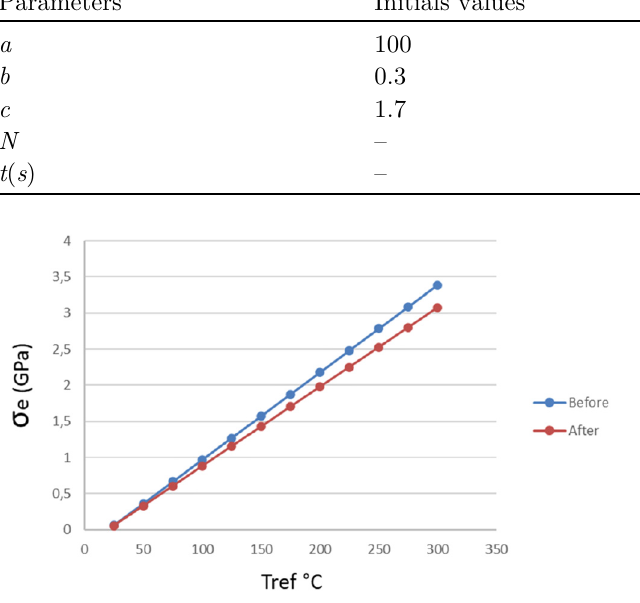
Fig. 10. Evolution of von Mises constraints before and after the optimization